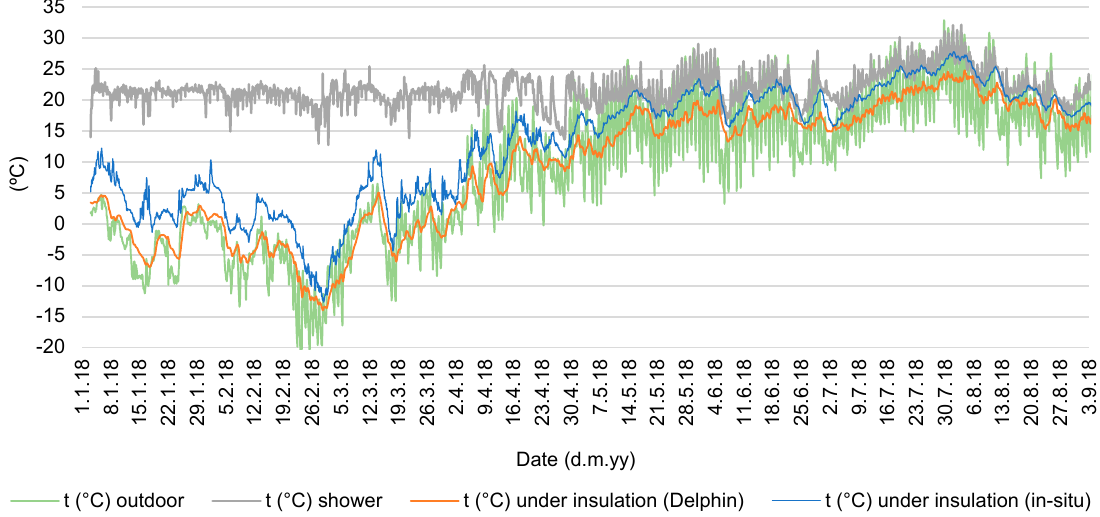
Figure 19. The temperature of the bathroom wall between dolomite and insulation layers: measured T (blue line), simulated T (orange line), indoor T (grey line), and outdoor T (green line).